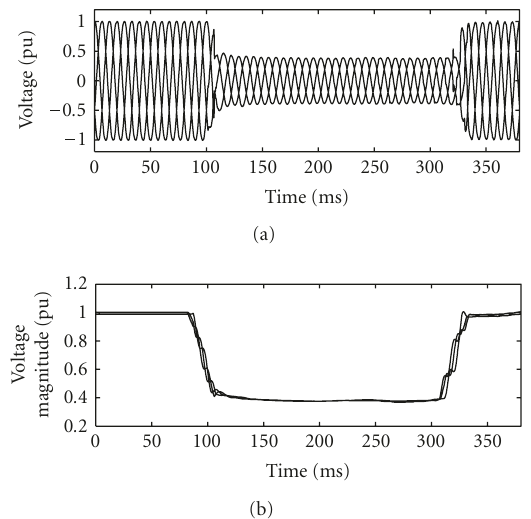
Figure 10: A self-extinguishing fault: (a) voltage waveforms; (b) voltage magnitude (measurement in a 10kV network).